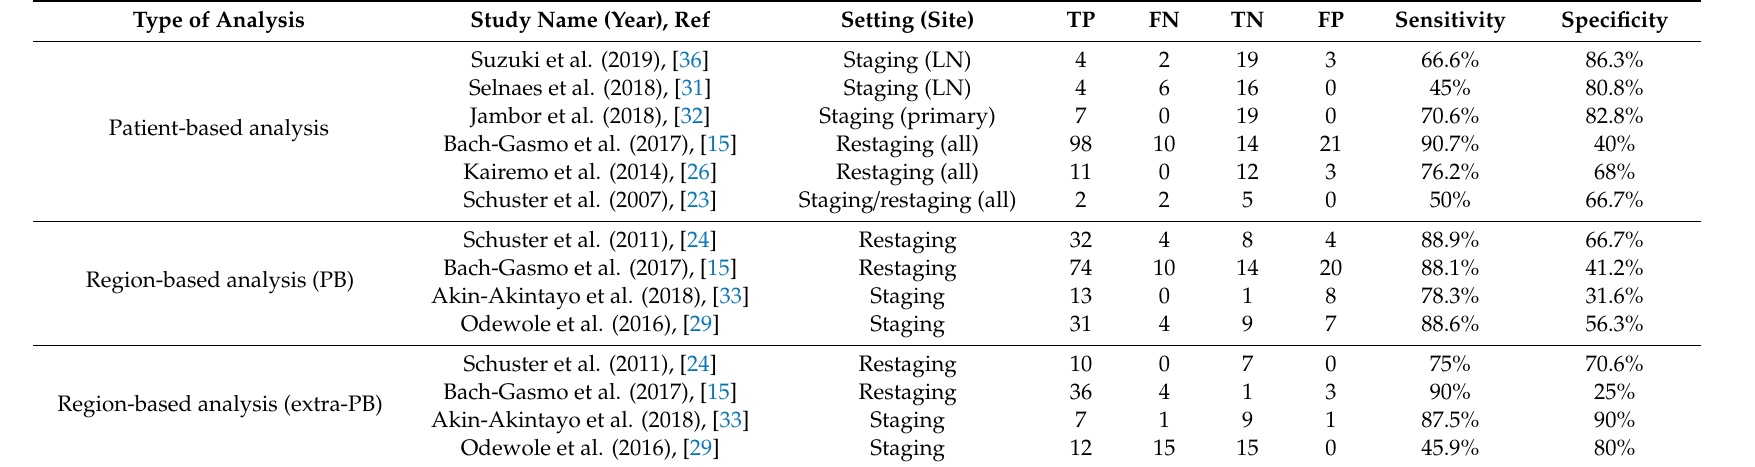
Table 3. Accuracies based on the study setting and the type of